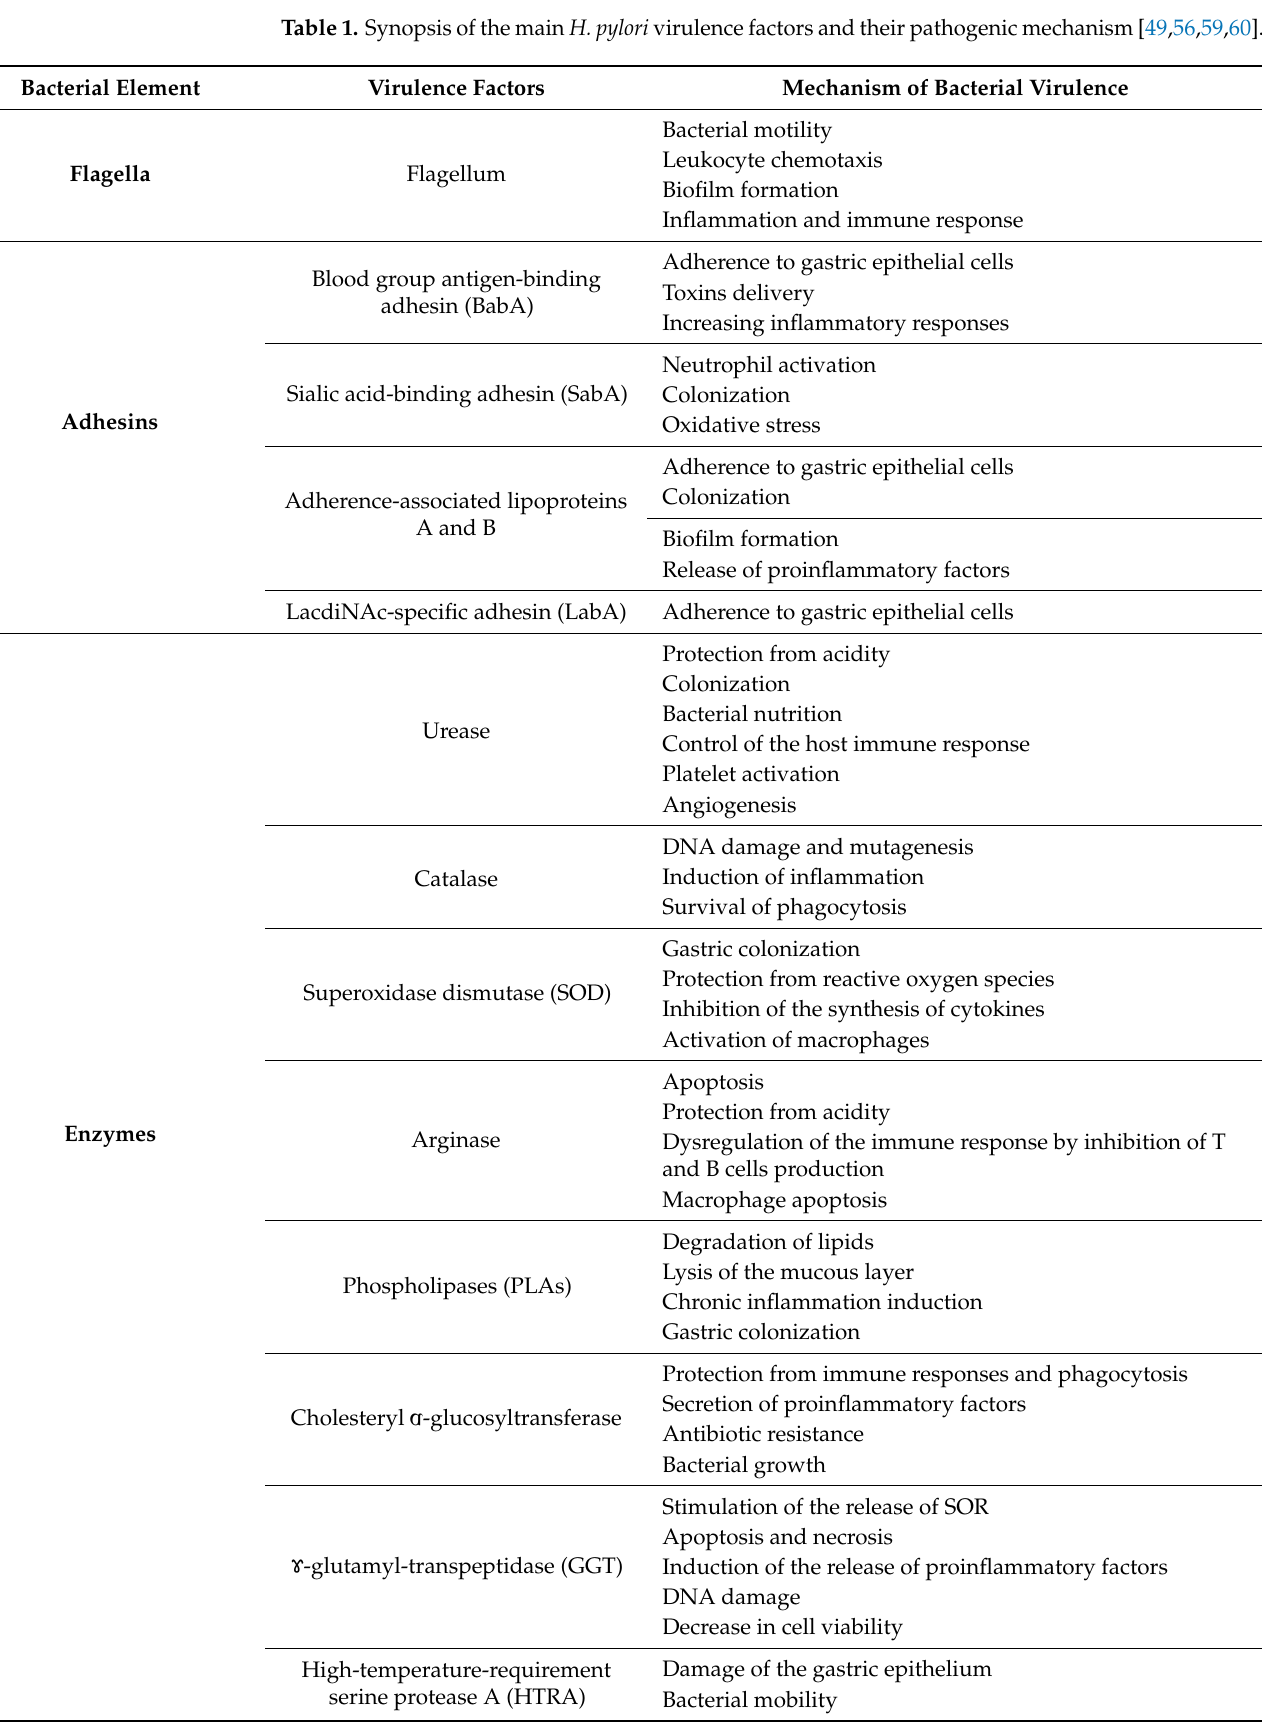
Table 1. Synopsis of the main H. pylori virulence factors and their pathogenic mechanism